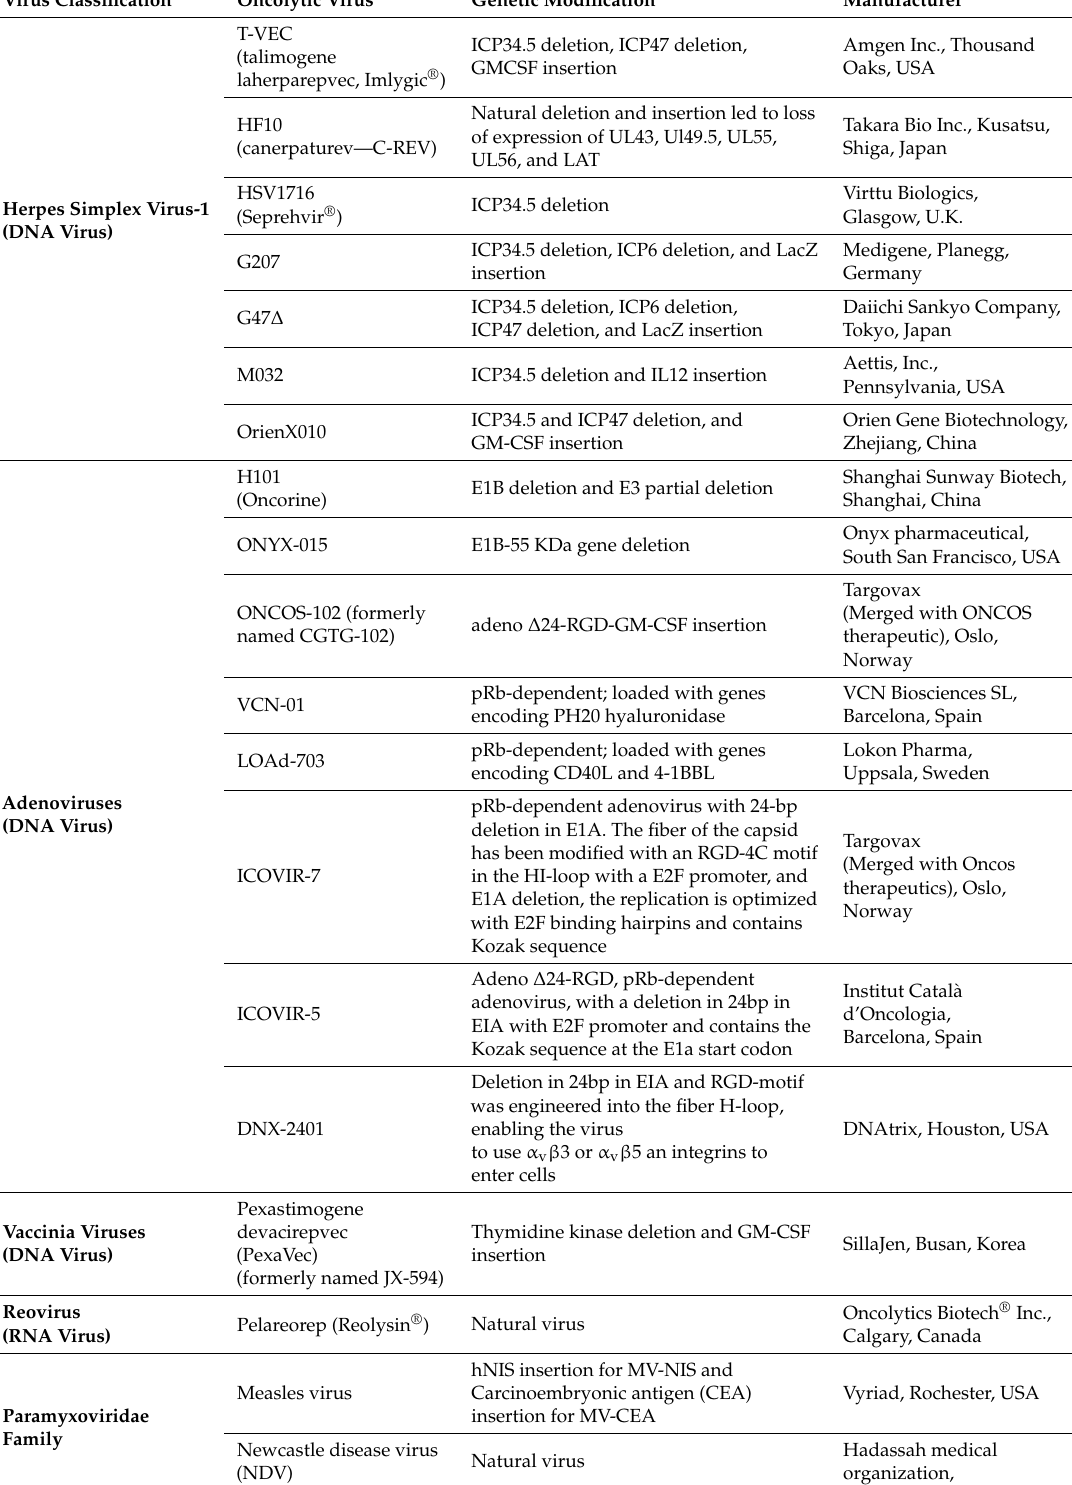
Table 1. Genetic modification of oncolytic